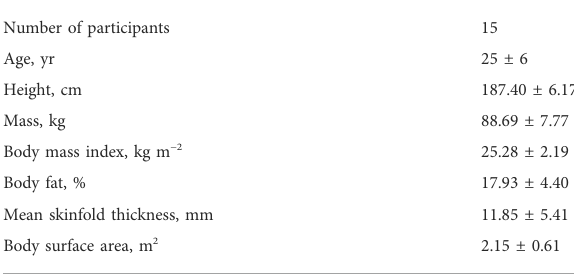
TABLE 1 Physical characteristics of the participants in the